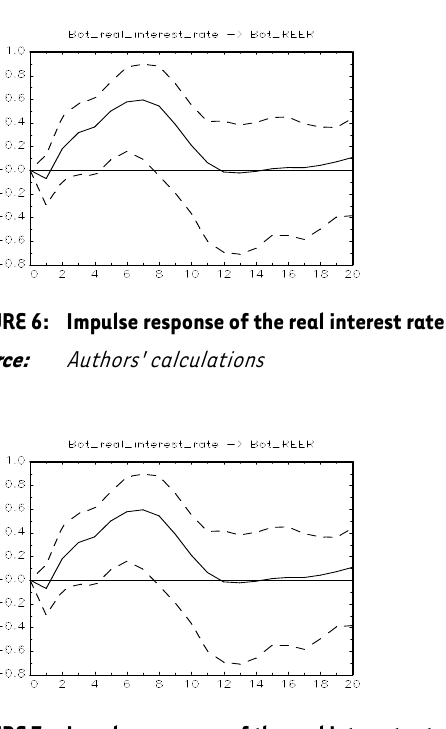
FIGURE 7: Impulse response of the real interest rate on REER Source: Authors'